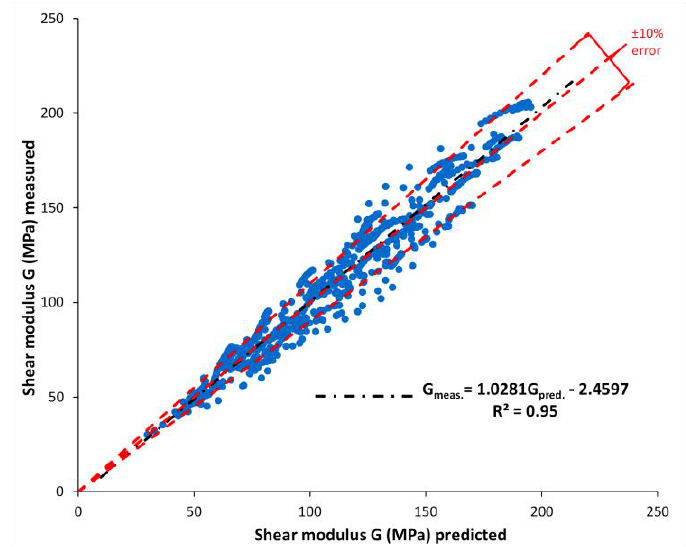
Figure 9. Measured versus predicted shear modulus by Equations (3) and (4).